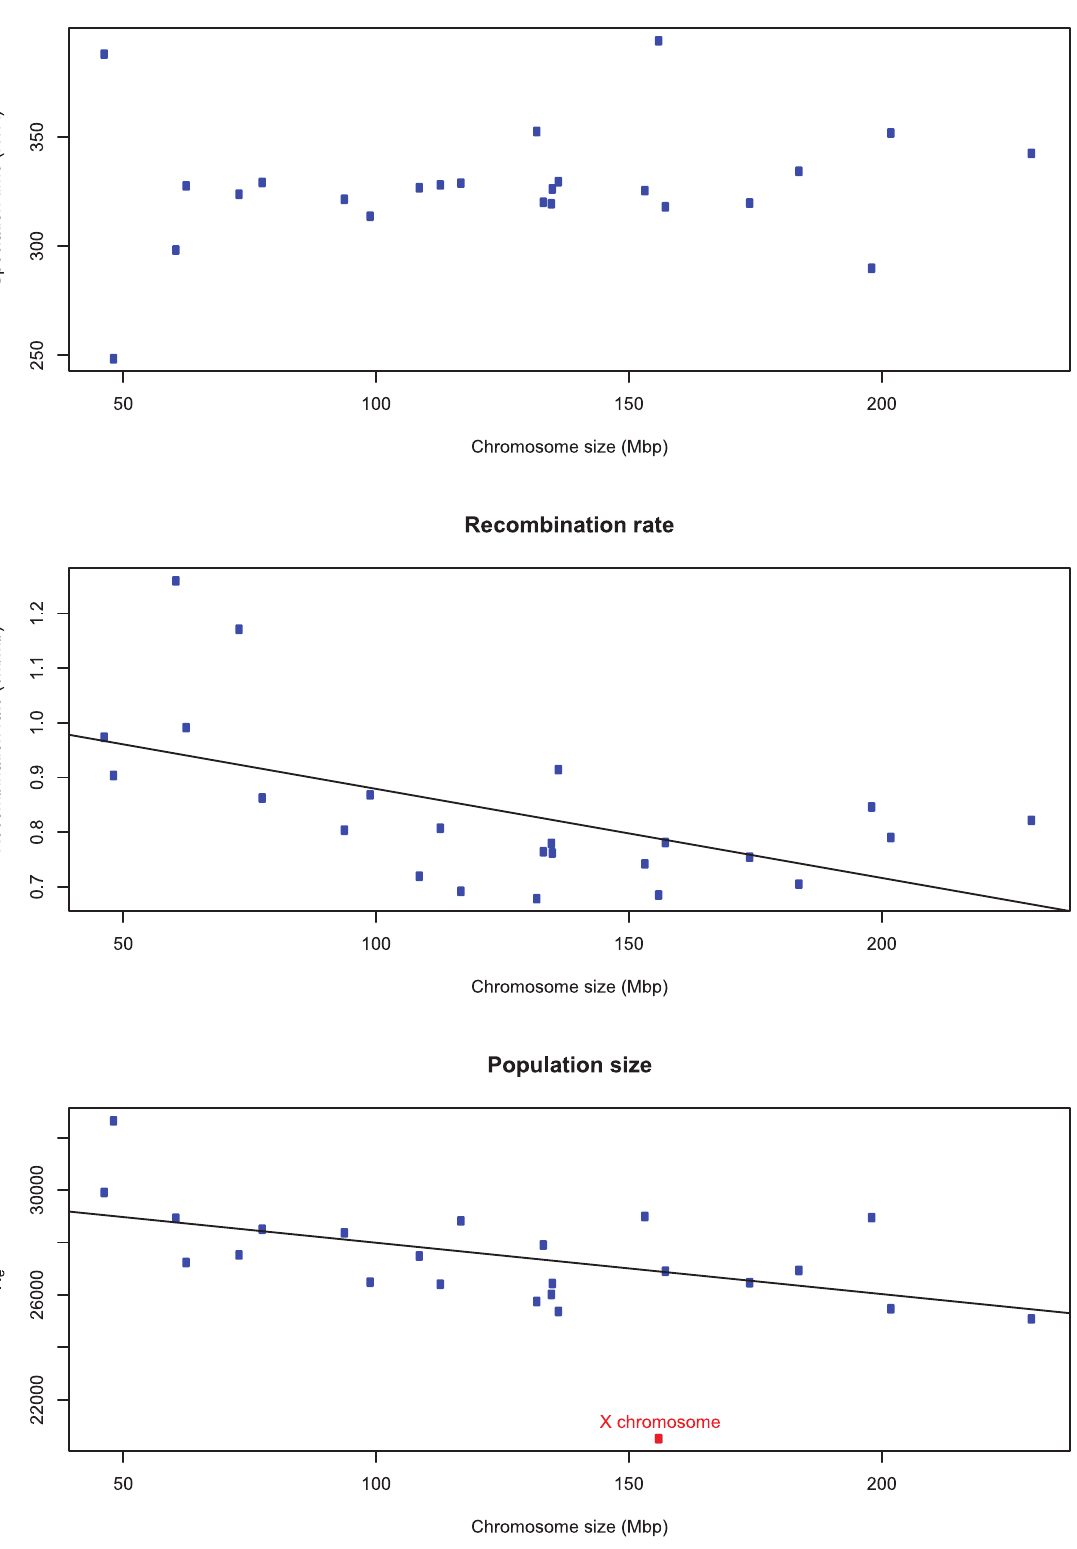
Figure 13. The correlation of inferred parameters with chromosome size. A) There is no correlation between the estimated sub-speciation time and chromosome size. B) A negative correlation between chromosome size and estimated recombination rate ( r 2 ~ 0 : 29, P ~ 0 : 00287 ). C) A negative correlation between chromosome size and inferred effective population size ( r 2 ~ 0 : 2969, P ~ 0 : 004226 ). The X chromosome was removed from the regression of effective population size. doi:10.1371/journal.pgen.1001319.g013 PLoS Genetics | www.plosgenetics.org 13 March 2011 | Volume 7 | Issue 3 |